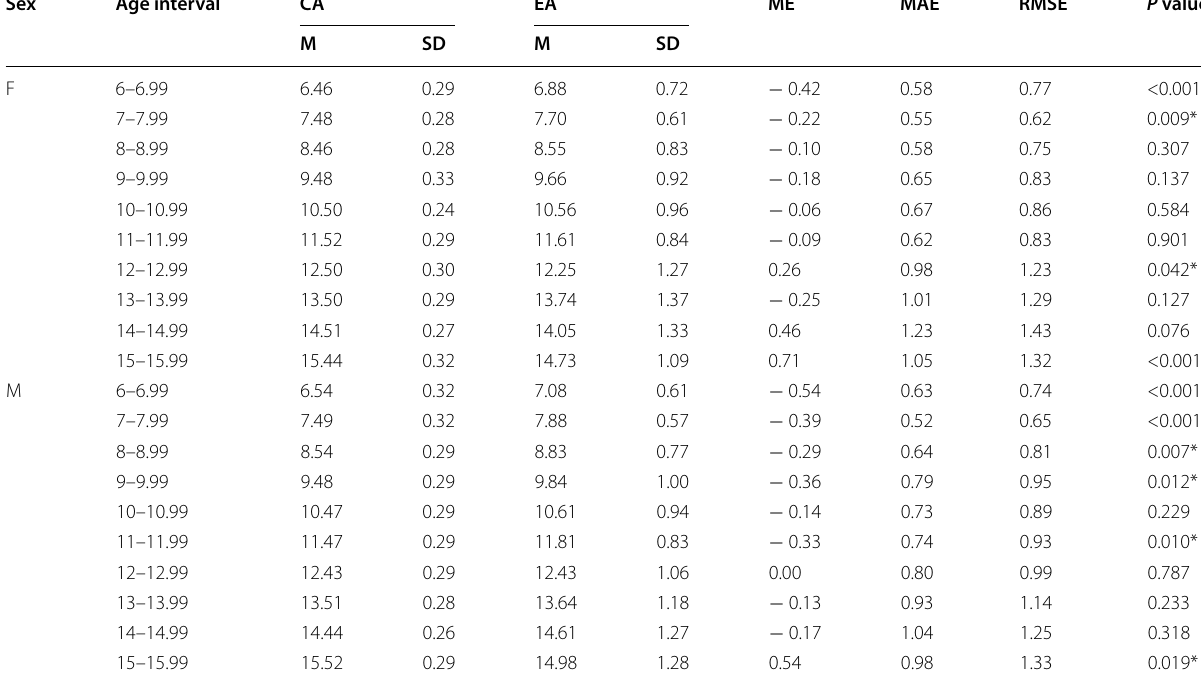
F females, M males, CA chronological age, EA estimated age, M mean, SD standard deviation, ME mean error, MAE mean absolute error, RMSE root mean squared error Age interval expressed in